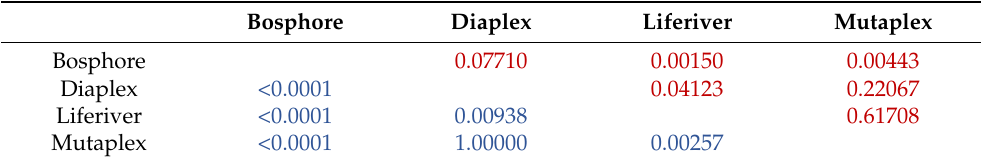
Table 5. Analysis of statistical differences for the studied RT-qPCR tests expressed as a p -value for two RNA extraction methods, blue—column-based and red—magnetic-based. Comparisons for paired nominal data were performed using chi-square McNemar’s Marginal Homogeneity Test. A p -value < 0.05 is statistically